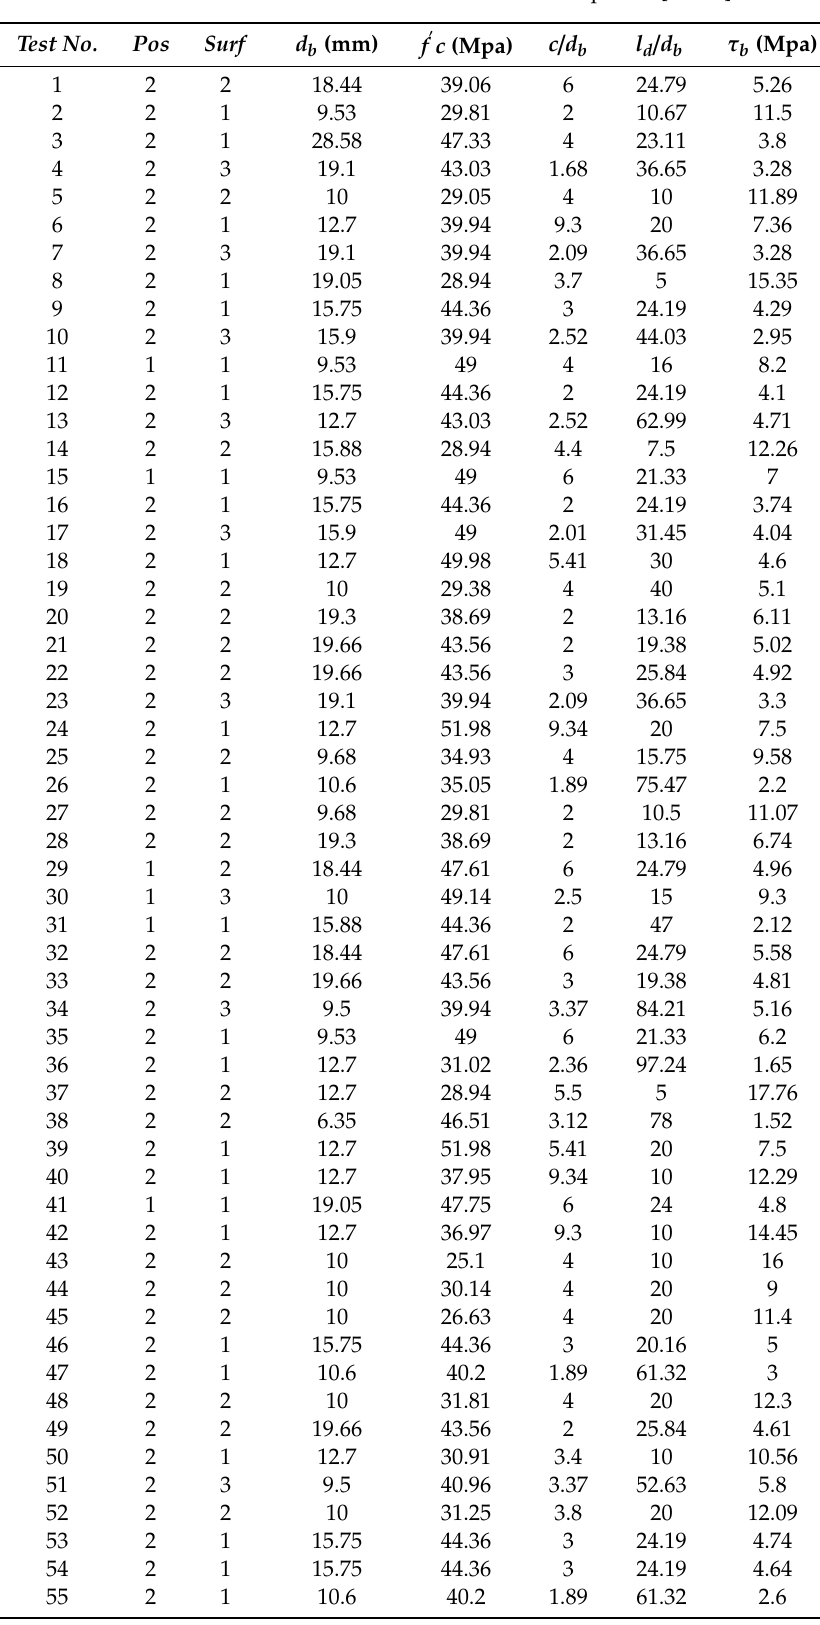
Table A1. The database used for the model development